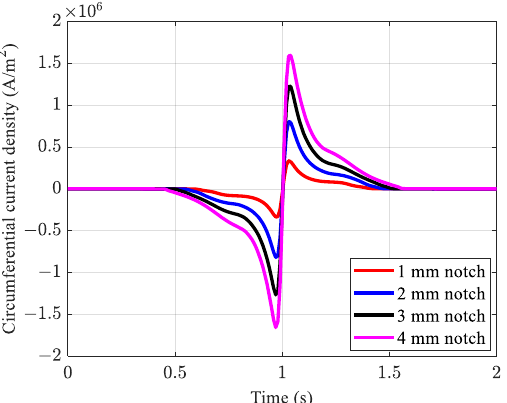
Figure 8. Circumferential current induction obtained using the proposed approximate numerical method.